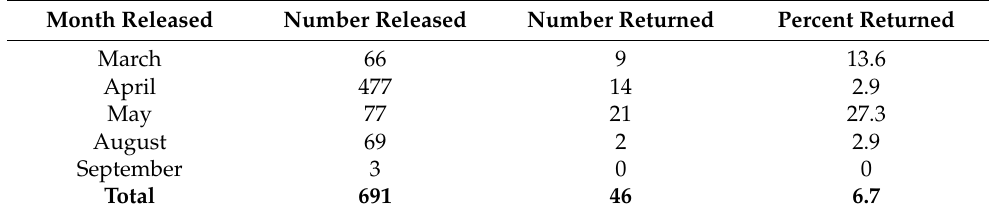
Table 3. Number of Northern Map Turtle hatchlings released into the Juniata River at Mount Union from 2001–2008, by month of release, and number that returned as reproductive adults from 2017–2022. Note: Of the 69 hatchlings released in August, 44 were incubated in the laboratory (rather than naturally incubated in the field), and none of those returned as